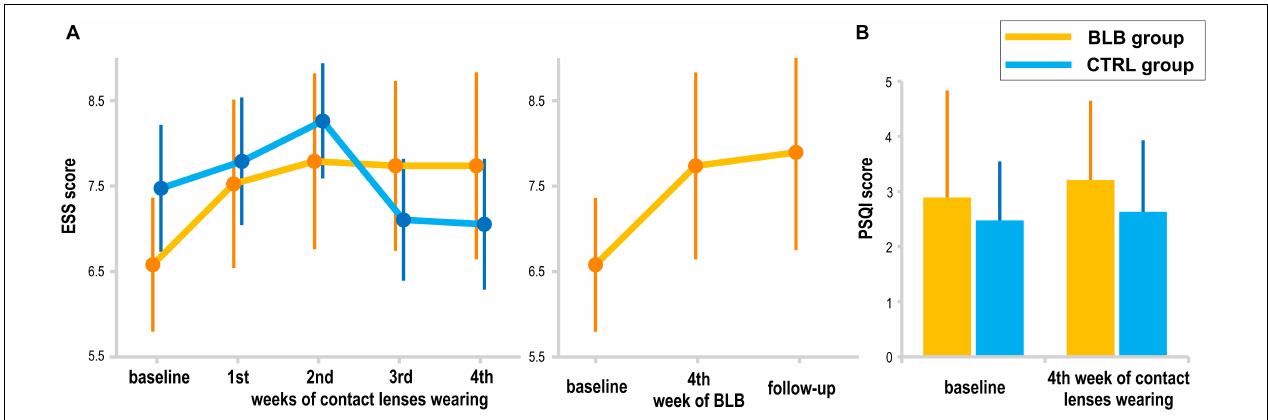
FIGURE 8 | Subjective measures of sleepiness and sleep quality: (A) Epworth Sleepiness Scale (EES) score for the blue light blocked (BLB) and control (CTRL) groups in consecutive experimental sessions as well as comparison to follow-up session for BLB group, (B) Pittsburgh Sleep Quality Index (PSQI) score at the baseline session and after 4 weeks of experimental condition for both groups. Bars indicate standard